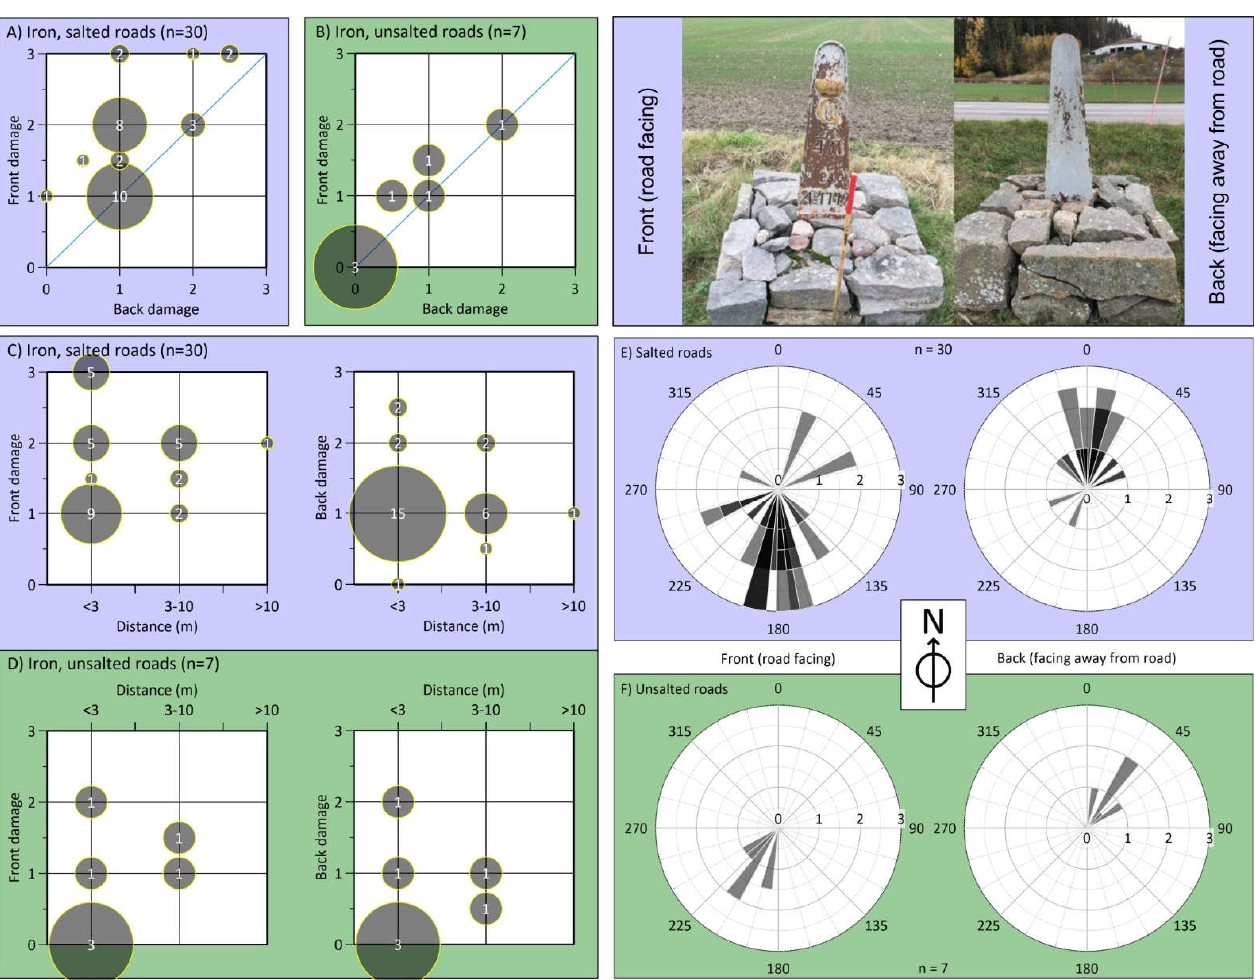
Figure 2. Bubble plots and wind rose diagrams showing milestone damage on a scale of 0 (none) to 3 (severe), with half marks where damage was difficult to classify. In the left hand panels, the radius of each bubble is proportional to the percentage of milestones in the sample group at the graph point (i.e. damage front vs damage back, damage vs distance), with actual numbers shown in the centre of the bubbles: ( A ) front and back on salted main roads; ( B ) front and back on un-salted roads; ( C ) and ( D ) damage in relation to distance from roads; ( E ) and ( F ) damage to front and back in relation to the compass direction in which each milestone faces. The upper right panel shows an example milestone with severe corrosion damage (photography by Hans Antonson 2020). (See Supplementary Data for the raw data).